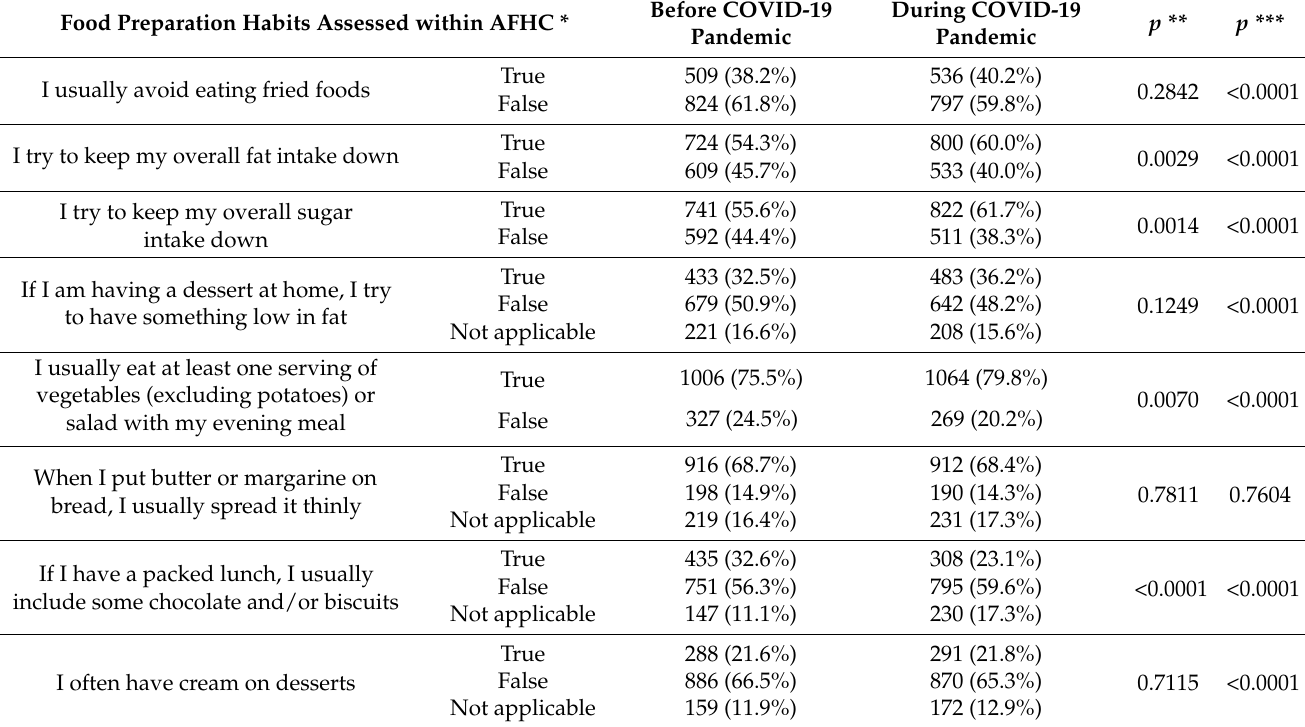
Table 2. The food preparation habits assessed while using Adolescents’ Food Habits Checklist (AFHC) in the period before the COVID-19 pandemic and during the COVID-19 pandemic, as declared by the adolescents from the Diet and Activity of Youth during COVID-19 (DAY-19) Study cohort ( n =